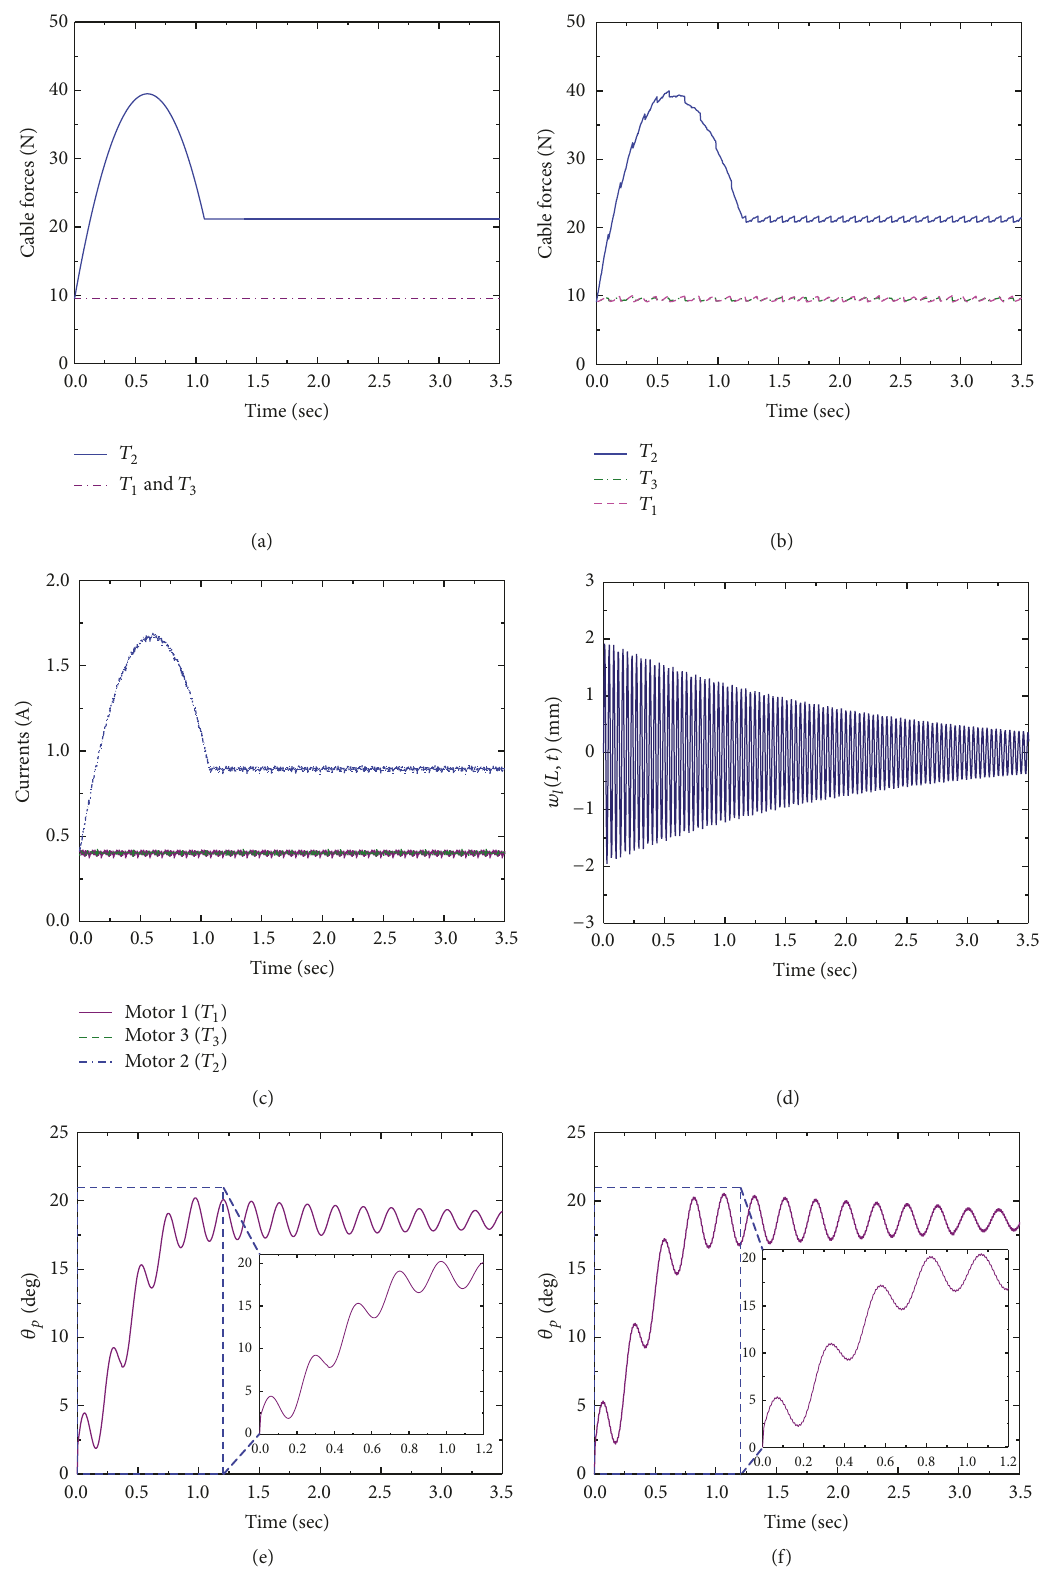
Figure 9: Responses of the system under open-loop: (a) theoretical results of all cable forces under open-loop, (b) experimental results of all cable forces under open-loop, (c) experimental results of all motor armature currents under open-loop, (d) theoretical transverse deformation result of the point 𝑜 under open-loop, (e) theoretical result of 𝜃 𝑝 under open-loop, and (f) experimental result of 𝜃 𝑝 under